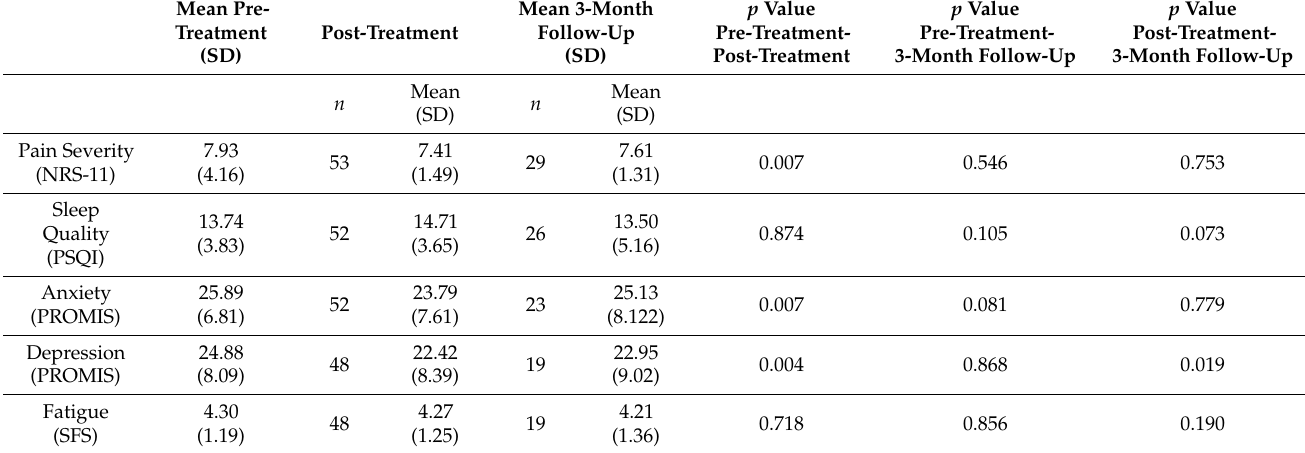
Table 1. Descriptive statistics and comparisons for the outcome